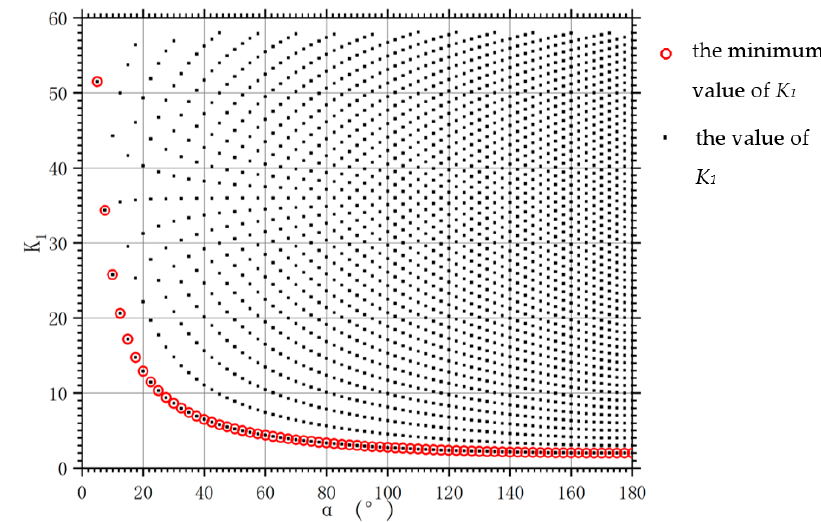
Figure 3. Distribution of K 1 relative to α calculated by MATLAB.